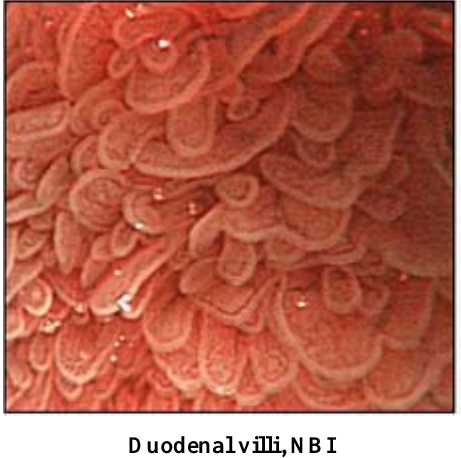
FIGURE 15. - Duodenum; villi of a normal size; narrow-band imaging coupled to magnification.The central axis of each villi is appearent.